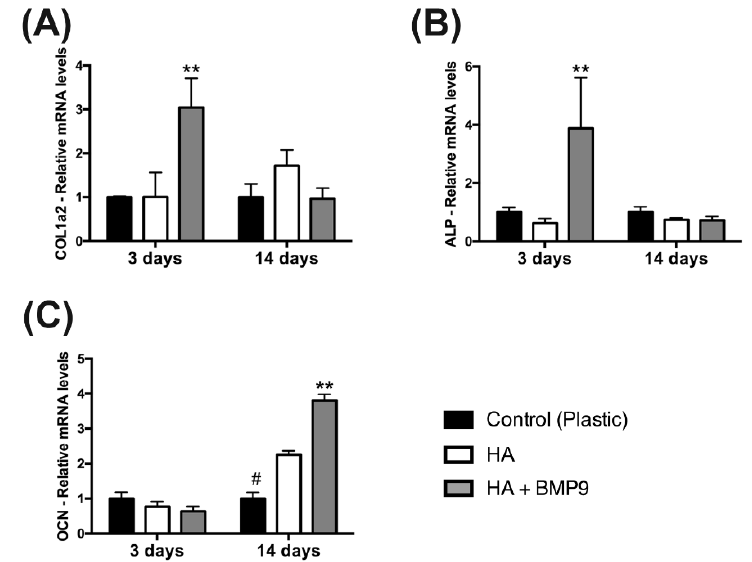
Figure 5. Real ‐ time PCR of ST2 cells seeded on (1) control tissue culture plastic, (2) control HA and (3) HA in combination with 100 ng/mL of rhBMP9 for genes encoding ( A ) collagen 1 α 2 (COL1a2), ( B ) alkaline phosphatase (ALP) and ( C ) osteocalcin (OCN) at three and 14 days post ‐ seeding (# denotes significantly lower than all other modalities, p < 0.05; ** denotes significantly higher than all other treatment modalities, p < 0.05).